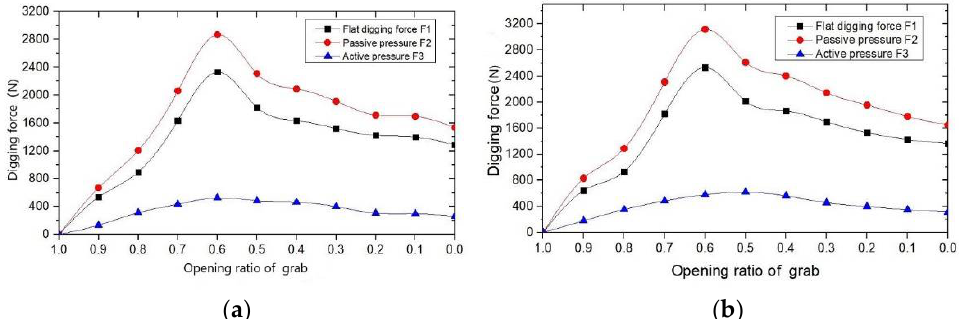
Figure 14. Digging force diagram: ( a ) Flat digging depth is 75 mm; ( b ) Flat digging depth is 100 mm.